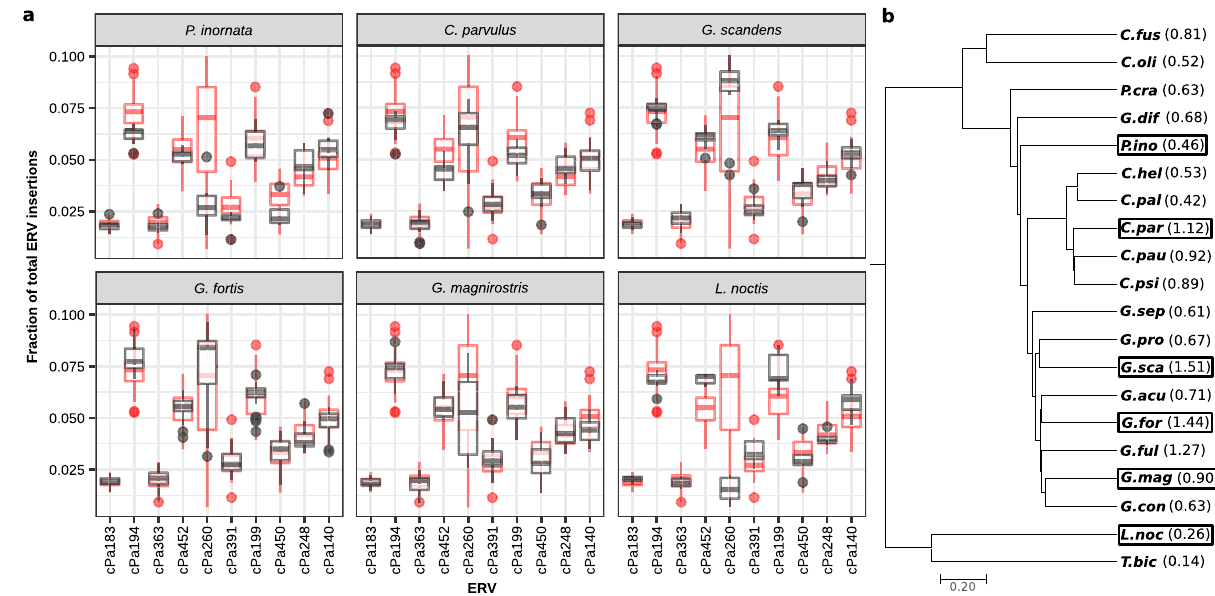
Fig. 4 | Relativeabundance ofcommonERVs inexample species. a The 10 most frequent ERVs showed signi fi cant variation in abundancebothwithin and between species. The relative fraction of insertions of an ERV within an individual was plotted as a data point in the box plots. Red data points are for all fi nch samples, and black is the subset corresponding to only the species in the labeled window. The boxplot bottom and top hinges represent 25% and 75% con fi dence respec- tively, and whiskers indicate the 95% con fi dence interval. Variation in relative